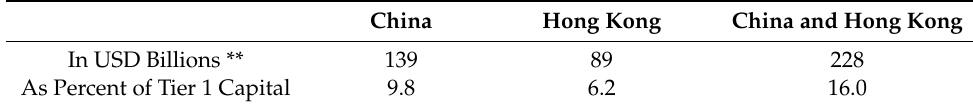
Table 1. U.S. bank claims to China and Hong Kong *.